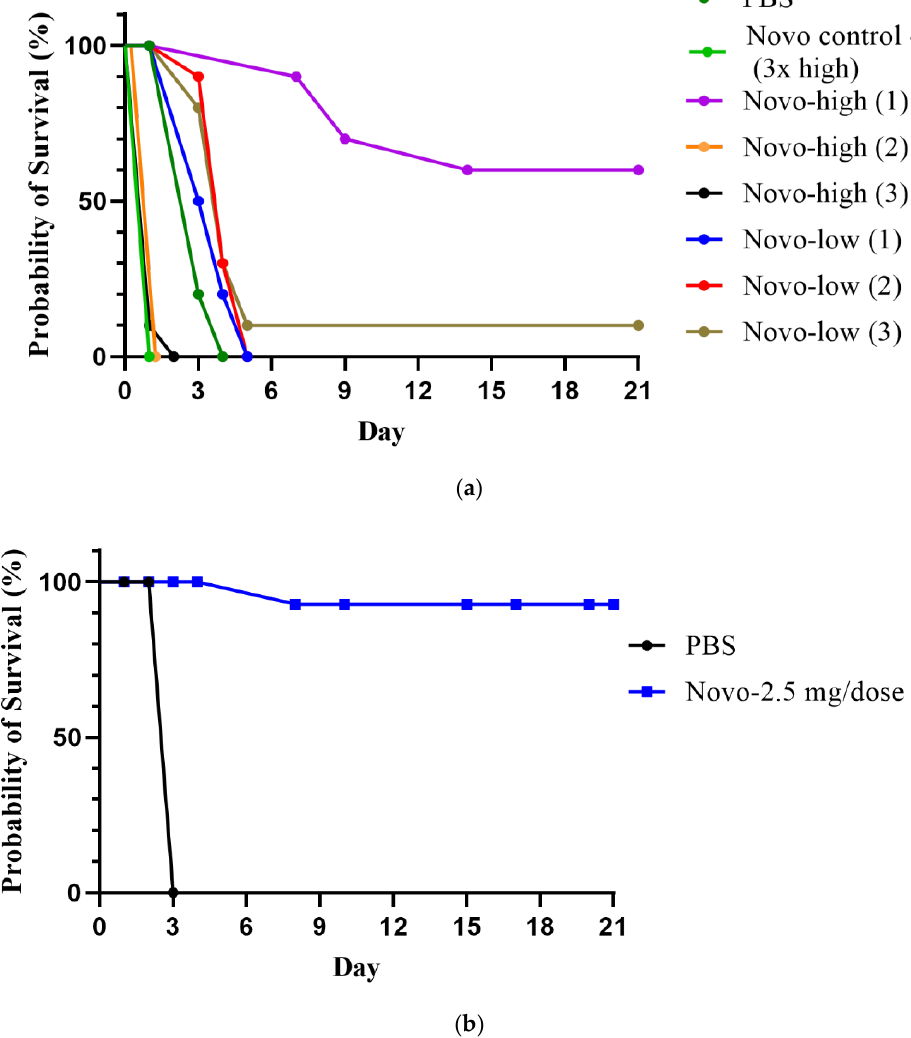
Figure 1. A/J mice infected via subcutaneous (SC) injection with B. anthracis Sterne spores and treated with Novo. ( a ) Mice were challenged with approximately 1.6 × 10 4 spores of B. anthracis Sterne (15 LD 50 ), and treatments consisted of a high (5.0 mg) or low (1.25 mg) dose of Novo administered via intraperitoneal [IP] injection. One, 2, or 3 doses of Novo were given post-challenge (1 h, 1 h and 8 h, or 1 h, 8 h, and 24 h). Mice were monitored for 21 days. ( b ) A second iteration of Novo with a potentially optimal dosing scheme. Mice were challenged SC with 1.1 × 10 4 spores of B. anthracis Sterne (10 LD 50 ) and treated with Novo (2.5 mg) at 1 h, 8 h, and 24 h post-challenge. All groups had 10 mice.